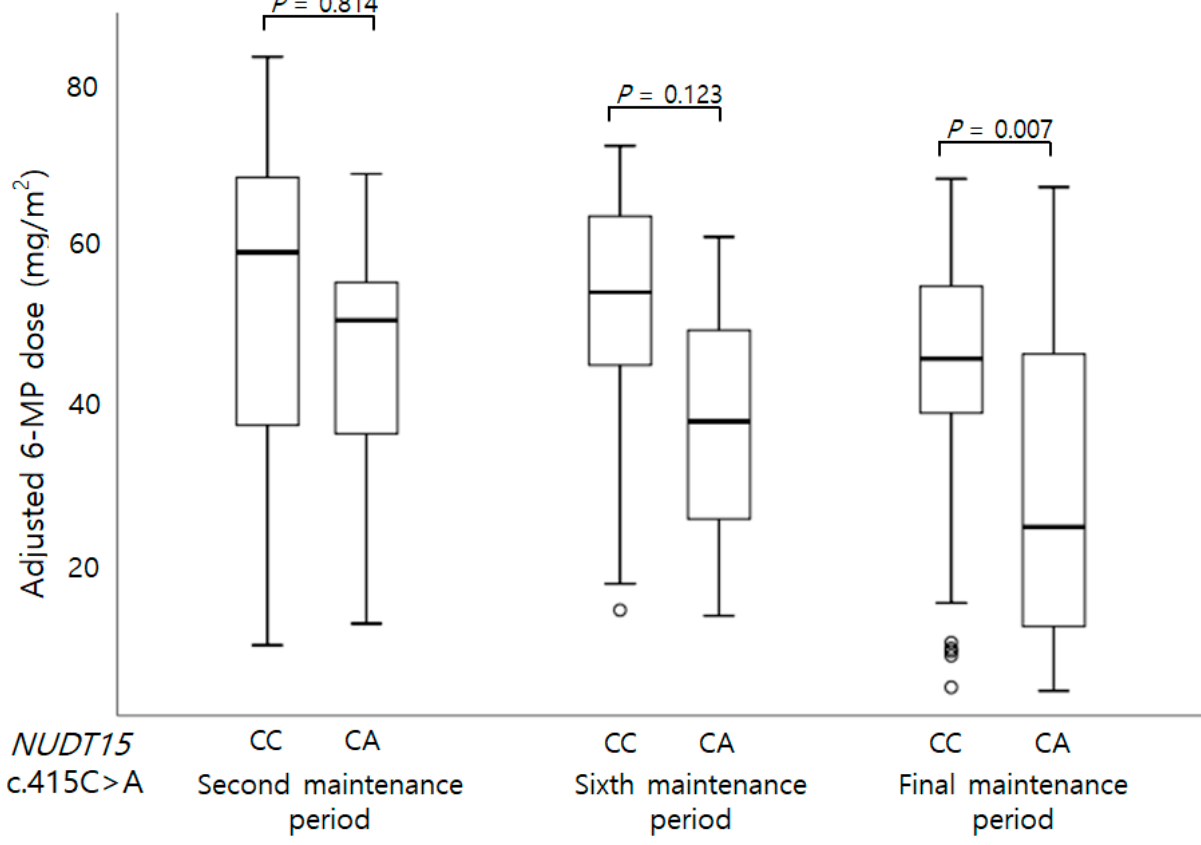
Figure 1. Genotype of NUDT15 c.415C>A and adjusted 6-MP dose at second, sixth, and final maintenance periods. The adjusted 6-MP dose at final maintenance period was significantly low in patients carrying CA heterozygote than those with wild CC genotype.